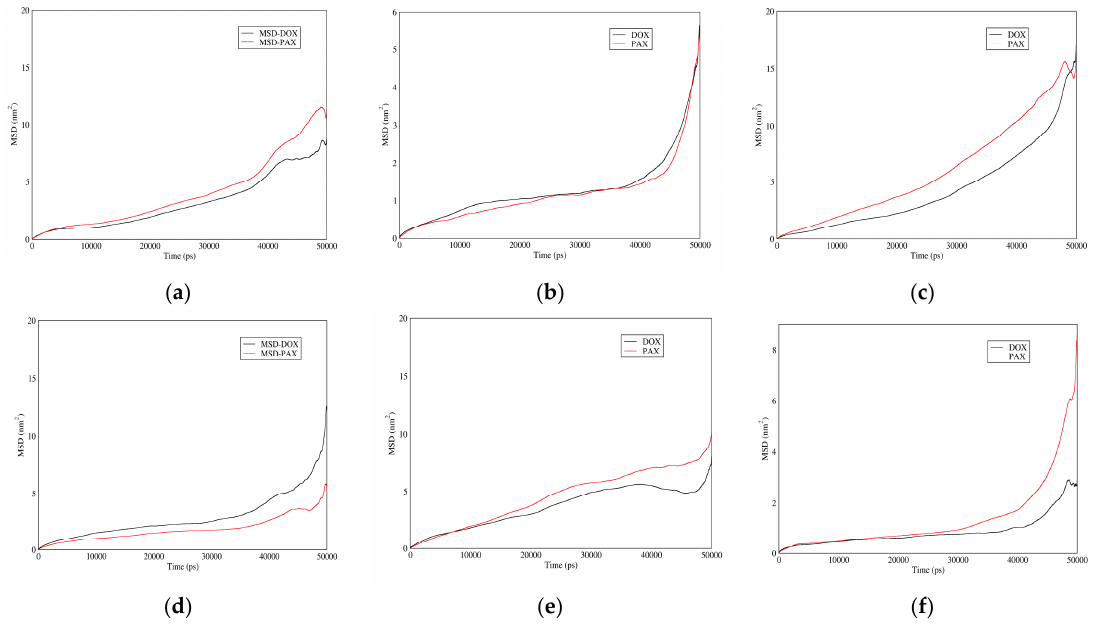
Figure 14. Mean square displacement of DOX and PAX versus time in neutral and acidic pH for different carriers: ( a ) CNT in neutral pH; ( b ) Fullerene in neutral pH; ( c ) GO in neutral pH; ( d ) CNT in acidic pH; ( e ) Fullerene in acidic pH; ( f ) GO in acidic pH.